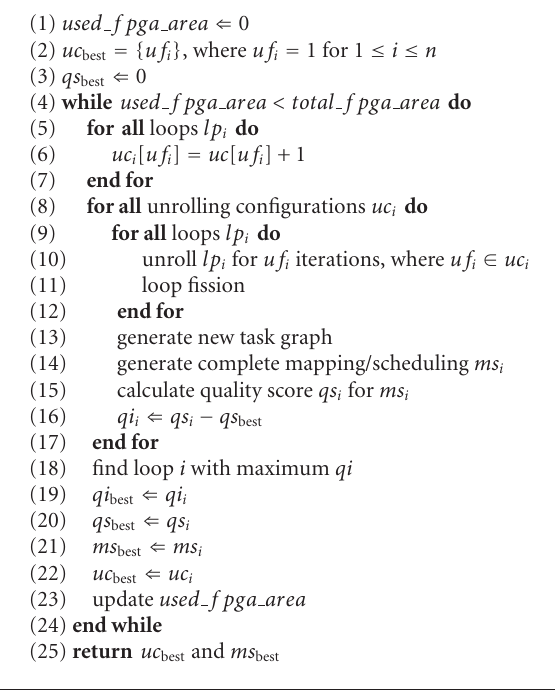
Algorithm 1: Search the best unrolling